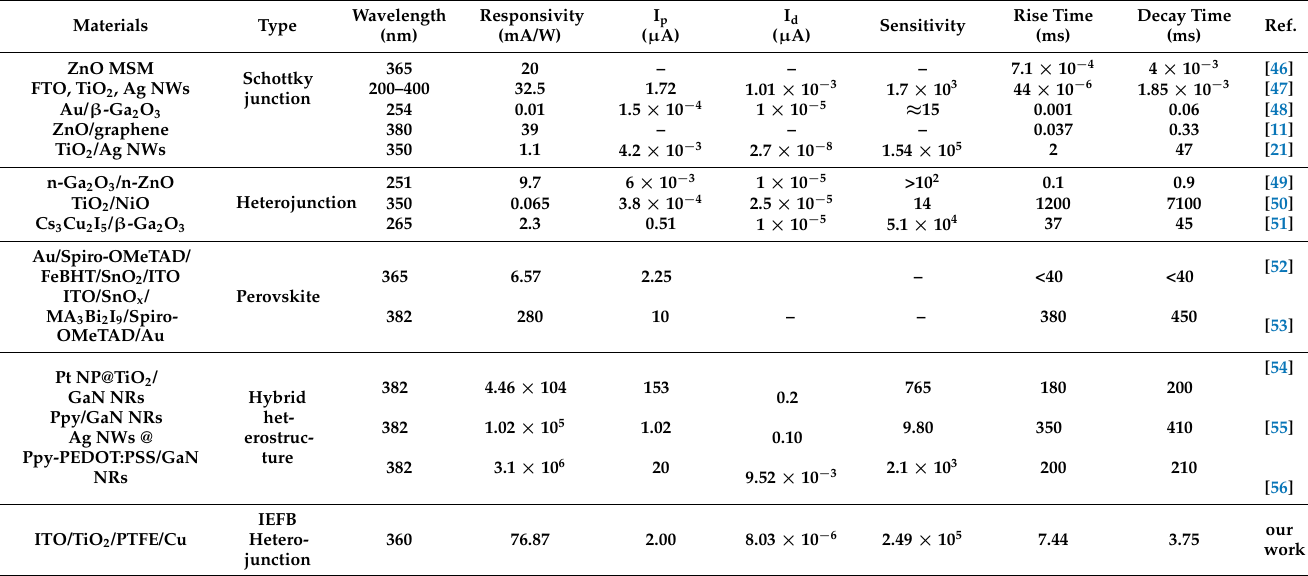
Table 1. Comparation of self-powered UV